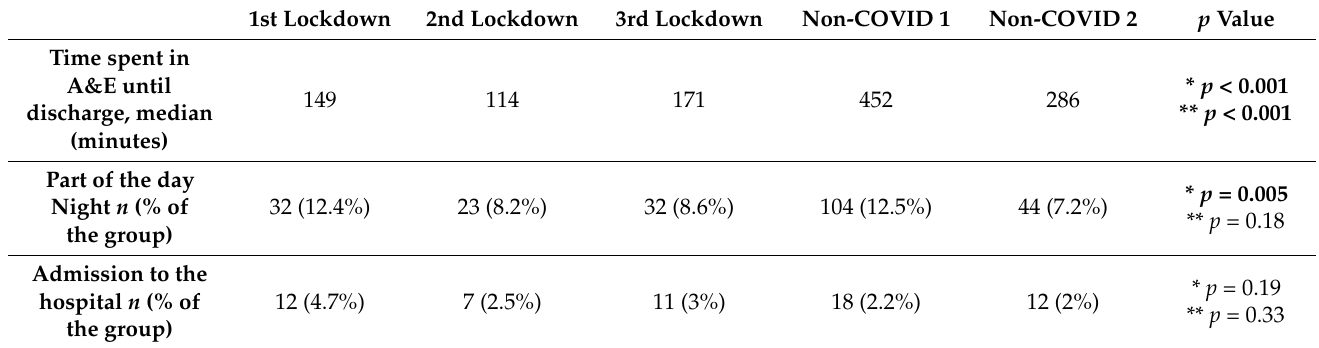
Table 2. Technical data on Emergency Department, Ophthalmology Unit, the Medical University of